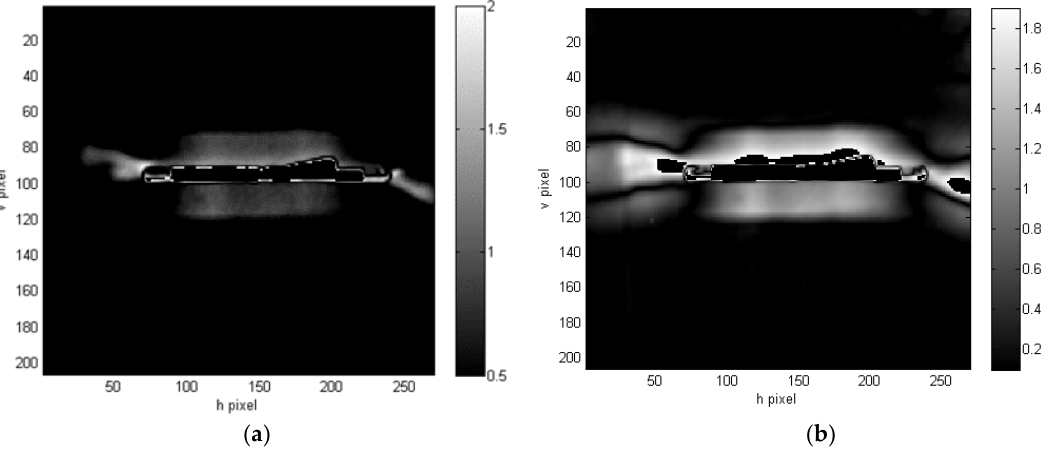
Figure 19. Contrast map of multi-stringer component using heating pulse of 3 s ( a ) and 10 s ( b ).